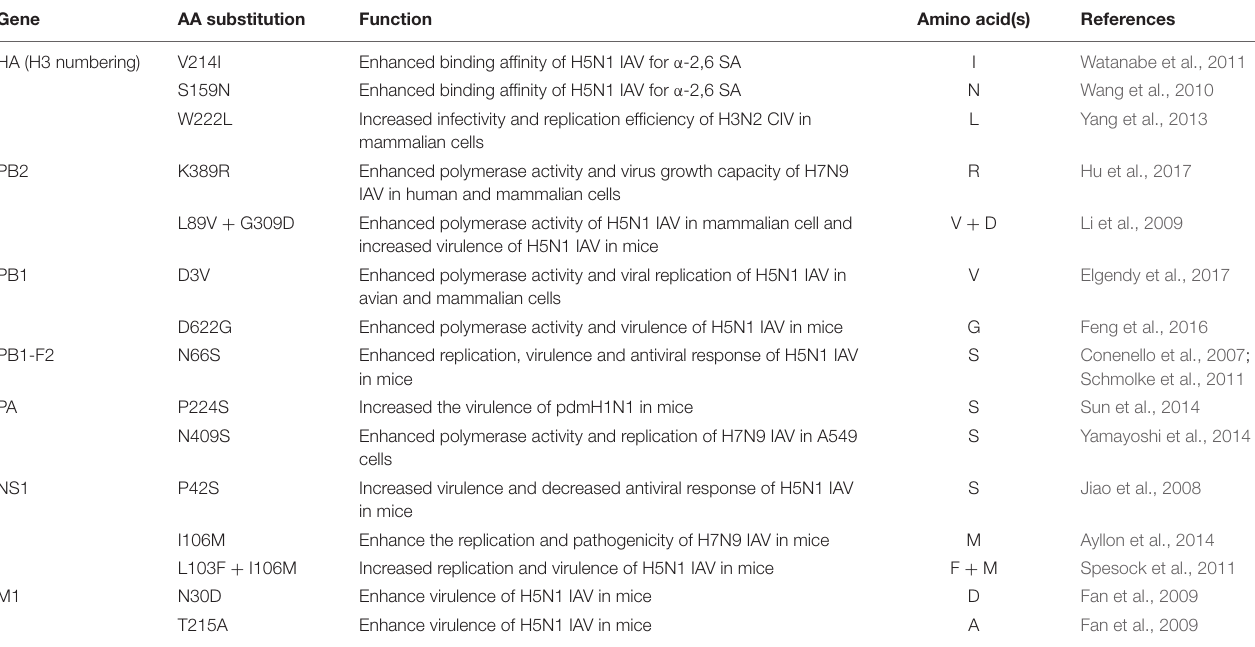
TABLE 1 | The major amino acids of CADY1/2019 that may affect functions.